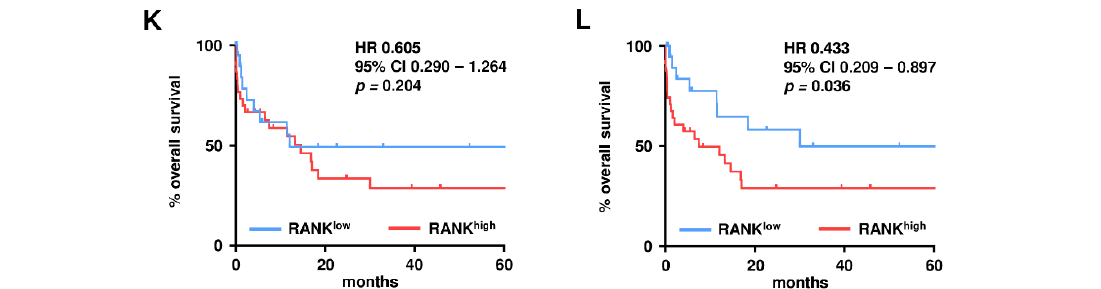
Figure 4. Association of RANK expression with clinical parameters and prognostic evaluation of RANK in AML. ( A ) Proportion of RANK + cells in primary AML samples are grouped according to the individual FAB type (left panel) and in immature (M0-2, n = 19) versus mature (M4-5, n = 29) FAB types (right panel; solid lines, median; dotted line, 10% RANK + cells). ( B - D ) Distribution of RANK expression (percentage of positive cells) in ( B ) AML patients below and above 60 years (<60 years, n = 24; ≥ 60 years, n = 30), ( C ) primary (pAML, n = 43) and secondary (sAML, n = 11) cases and ( D ) NCCN risk groups (favorable, n = 16; intermediate, n = 23; poor, n = 4) is shown. ( E ) Proportion of RANK + cells in 54 primary AML samples are plotted against WBC counts. ( F ) AML cases positive ( n = 16) or negative ( n = 23) for NPM1 mutations are shown. ( G,H ) Overall survival of 54 AML patients grouped into quartiles according to ( G ) percent RANK + cells and ( H ) SFI levels are depicted (first to fourth quartile, low to high proportion of RANK + cells and SFI levels, respectively). ( I,J ) Separation into RANK low and RANK high patient groups using the cut-off value of ( I ) 11% positive cells and ( J ) an SFI of 1.2 is shown. ( K , L ) Overall survival of patients assigned to the RANK low and RANK high groups based on the cut-off value of ( K ) 11% positive cells and ( L ) an SFI of 1.2 (HR, hazard ratio; CI, confidence interval).